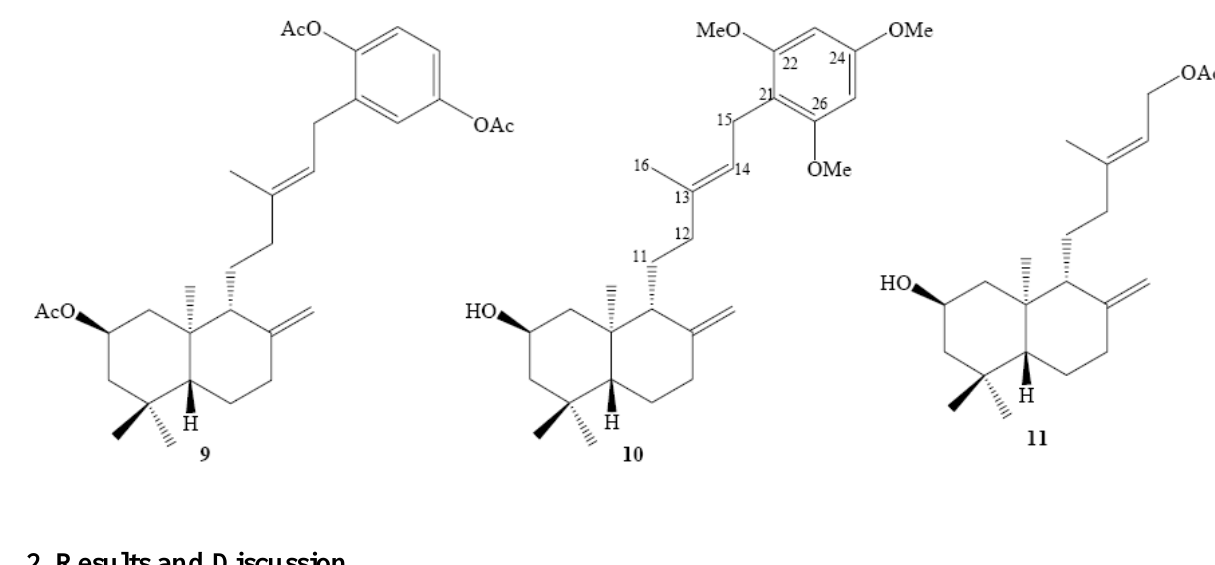
Figure 3. New diterpenylhydroquinone derivatives of natural ent